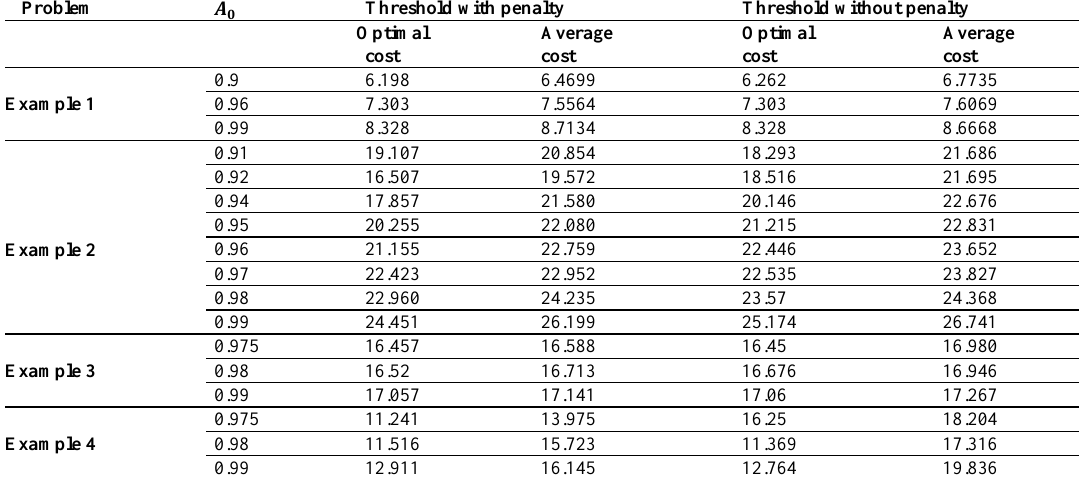
Table 8. Results obtained by TA with and without penalty in case of multi-state systems. Problem